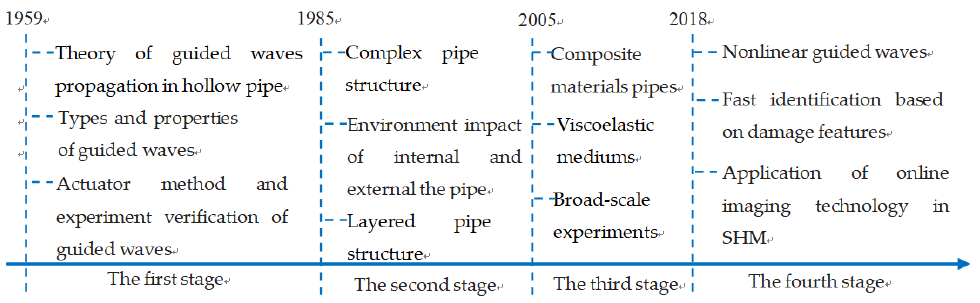
Figure 1. Ultrasonic guided waves damage identification stage [30 – 34].